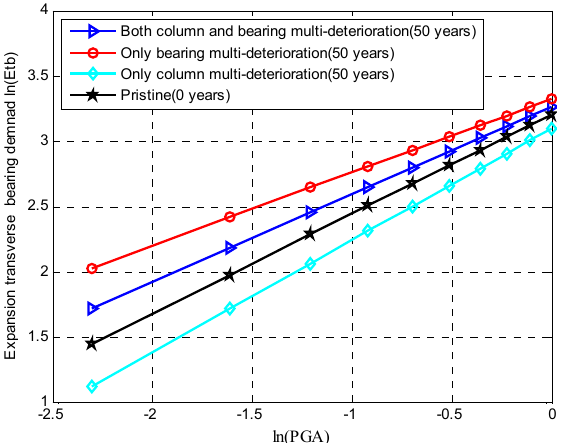
Figure 14. Mean values of the demand placed on an expansion bearing in the transverse direction using a PSDM.